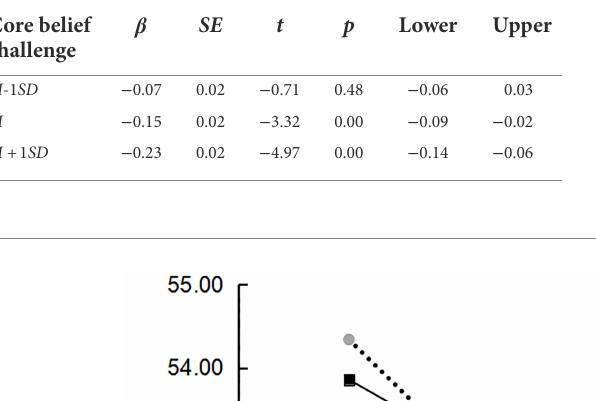
TABLE 5 Influence of PTG on academic burnout at different levels of core belief challenge.